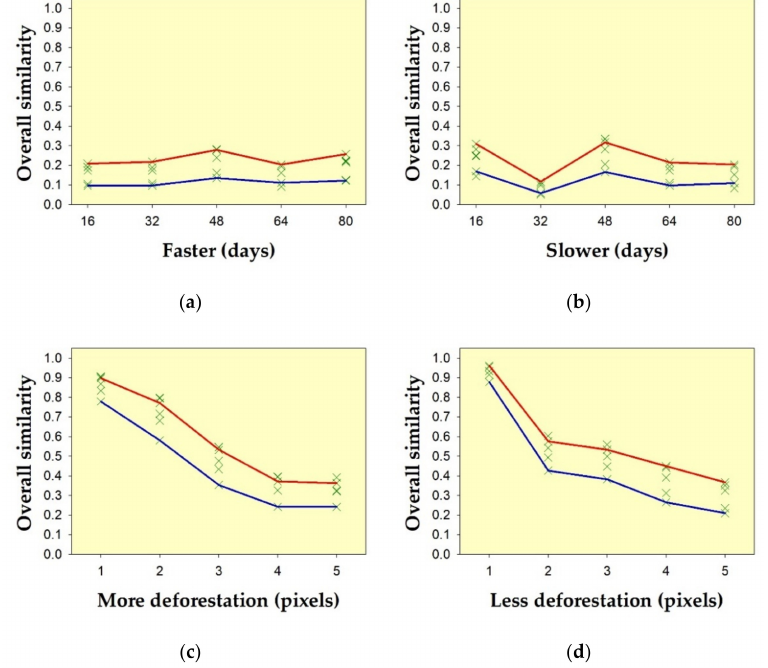
Figure 20. Sensitivity of the method on hypothetical deforestation temporal data sets after normal- ization, due to possibility of: ( a ) acceleration, ( b ) delay, ( c ) overestimation, and ( d ) underestimation of deforestation detection, compared to the reference. Green crosses indicate the overall similarity (i.e., the average similarity of θ and similarity of δ ) from all nine metrics. Red lines on the upper edge of the envelopes indicate the overall similarity using the Fidelity metric. Blue lines on the lower edge of the envelopes indicate the overall similarity using the metric of